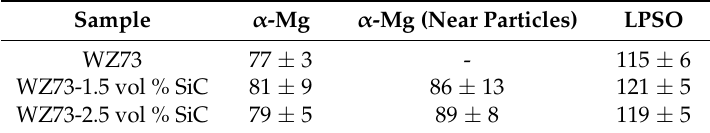
Table 3. Vickers hardness (HV) of the selected areas in the tested alloys.